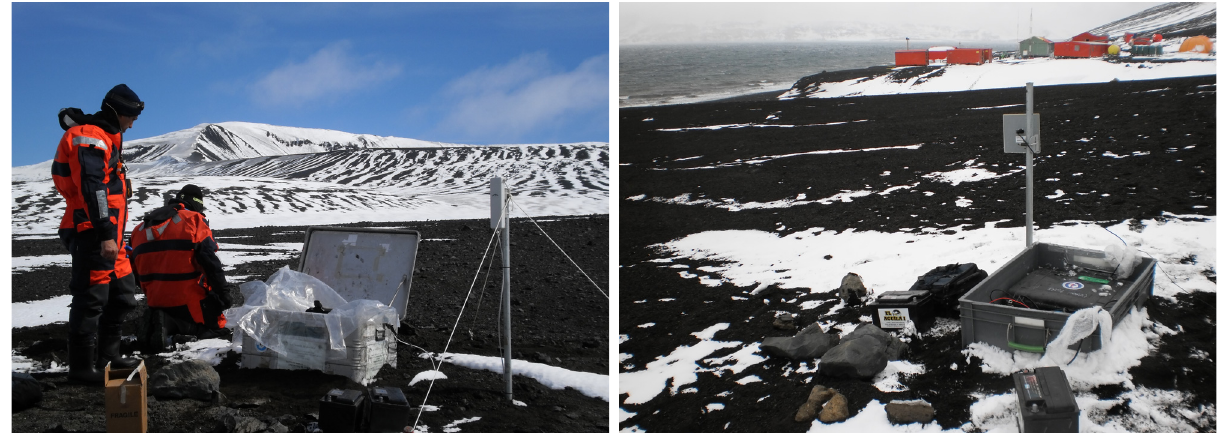
Figure 8. View of the seismic network stations located at Obsidianas Beach (left) and at the Gabriel de Castilla Base (right) during the 2010- 2011